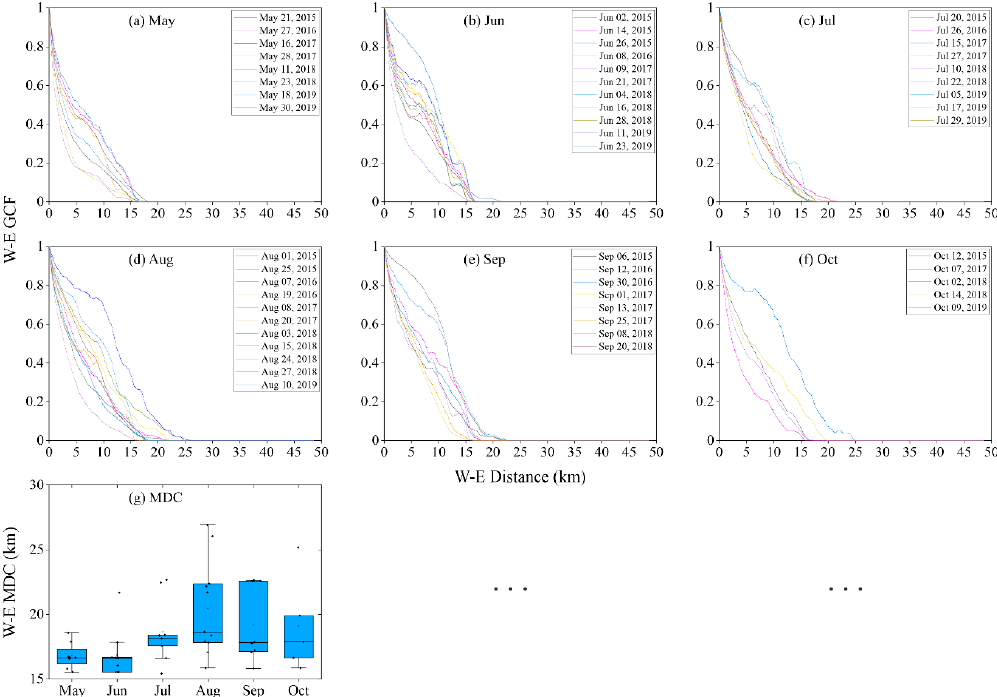
Figure 5. Changes in geospatial connectivity function (GCF) and maximum distance of connection (MDC) in the W–E direction of the Momoge National Nature Reserve, China from 2015 to 2019. ( a – f ) indicate May to October and ( g ) indicates MDC.